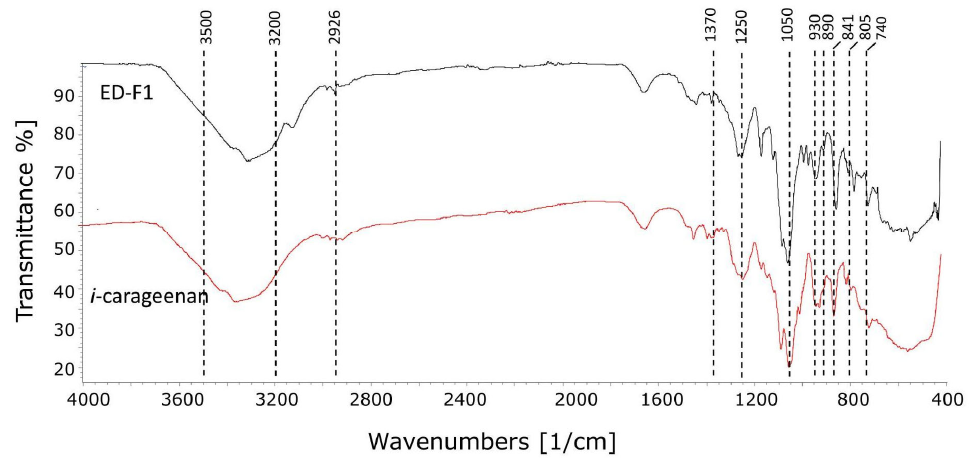
Figure 6. FT ‐ IR spectroscopy of E. denticulatum ED ‐ F1 fraction in comparison with i ‐ carrageenan Figure 6. FT-IR spectroscopy of E. denticulatum ED-F1 fraction in comparison with i -carrageenan standard (4000–400 cm 1 ). standard (4000–400 cm − 1